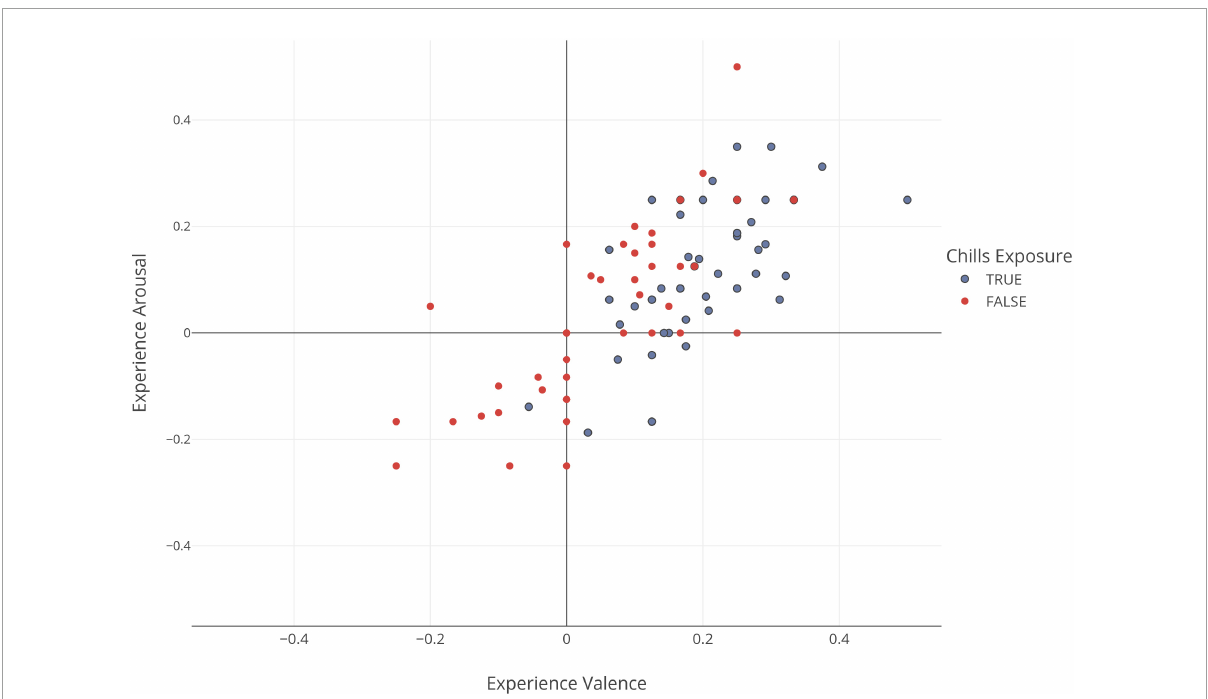
FIGURE4 Ratings of the experience in terms of valence and arousal for each stimulus (ratings were normalized from –0.5 to 0.5). The blue dots indicate mean rating in valence and arousal for stimuli which induced chills in participants while the orange dots indicate the mean valence and arousal ratings of stimuli which did not induce chills. We see that the majority of stimuli’s ratings tend to cluster in the top right quadrant, whereas the bottom left quadrant is mostly populated by ratings of stimuli who did not cause the chills. Essentially, this suggests that the chills response influences the participant’s perception of the